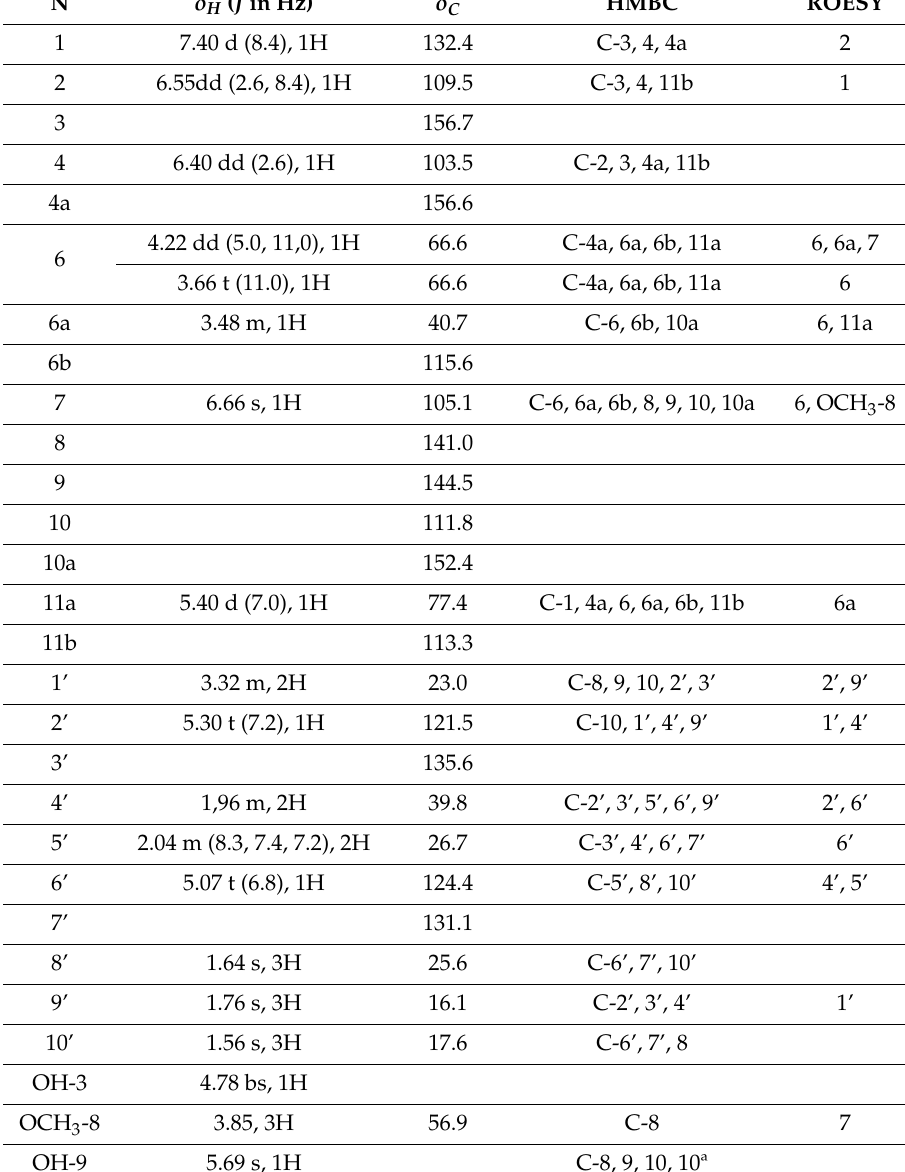
Table 1. 1 H (700 MHz), 13 C (175 MHz), and HMBC NMR data for compound 7 ( δ in ppm, J in